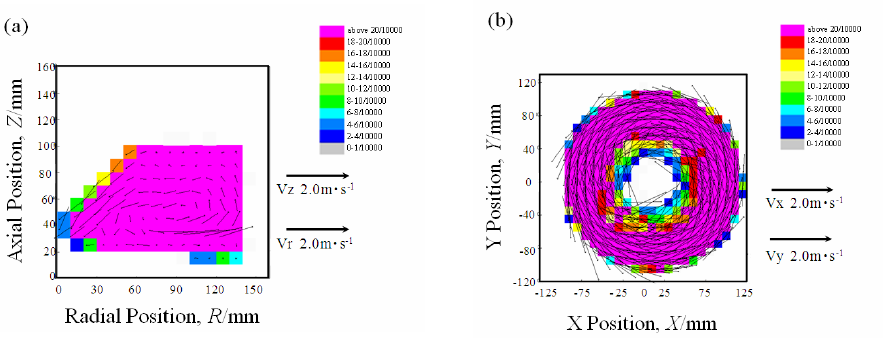
Fig.4 Particulate motion within the mixer using 3 beveled blades, impeller speed =600 rpm. (a) Side view and (b) top view